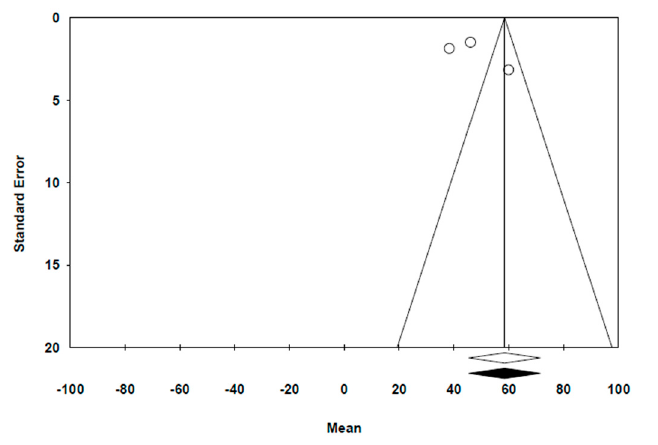
Figure 7. Funnel Plot with trim and fill (Duval and Tweedie).